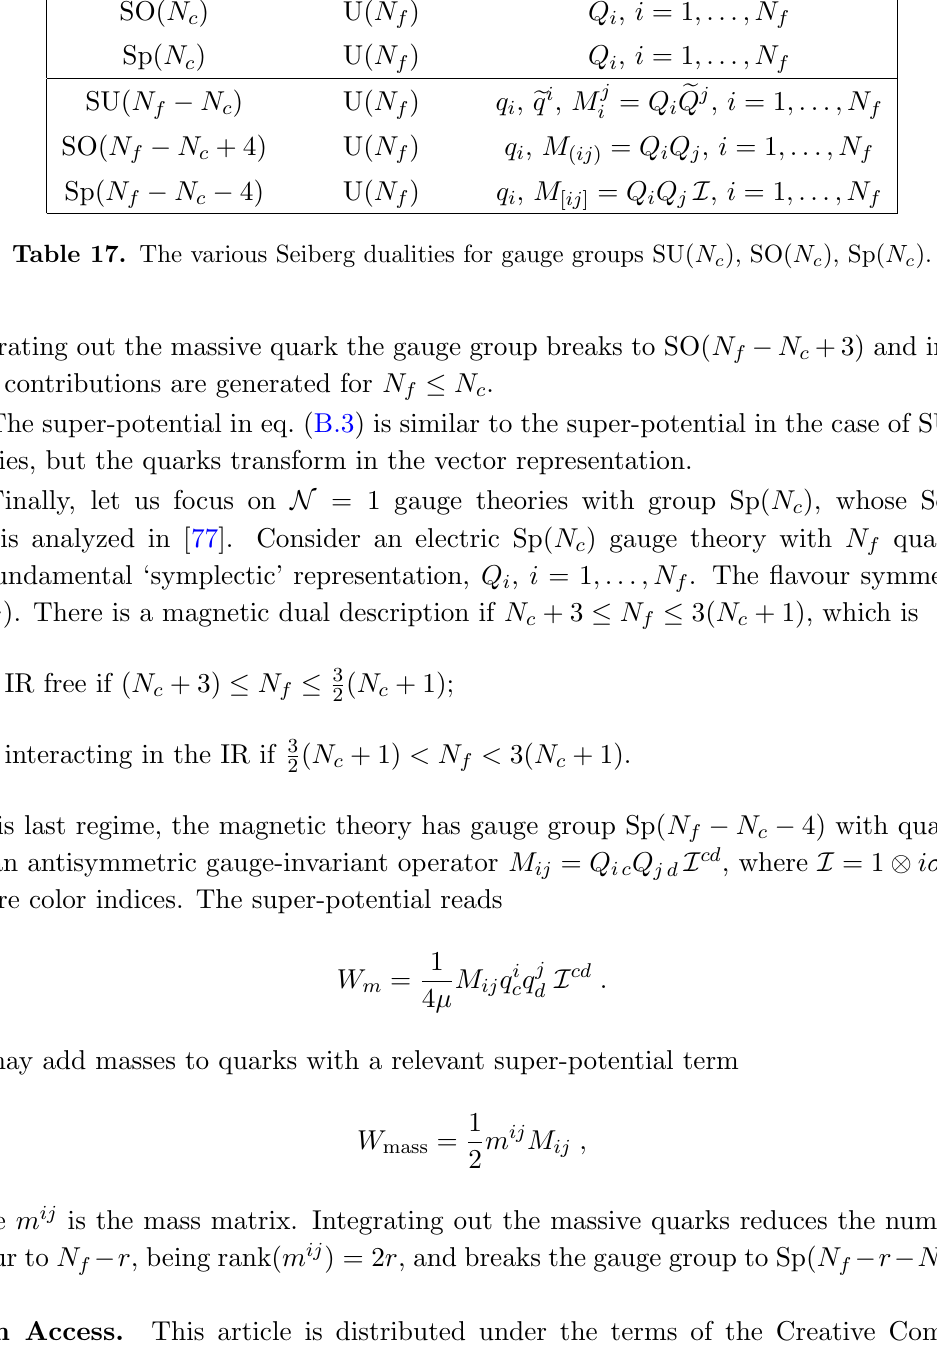
Table 17. The various Seiberg dualities for gauge groups SU( N c ), SO( N c ), Sp( N c ).